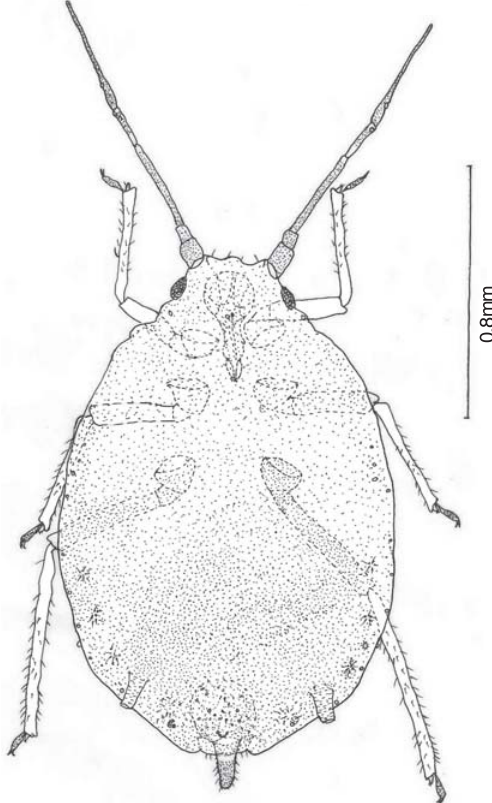
Figure 6. Rhopalosiphum rufiabdominalis (Sasaki)